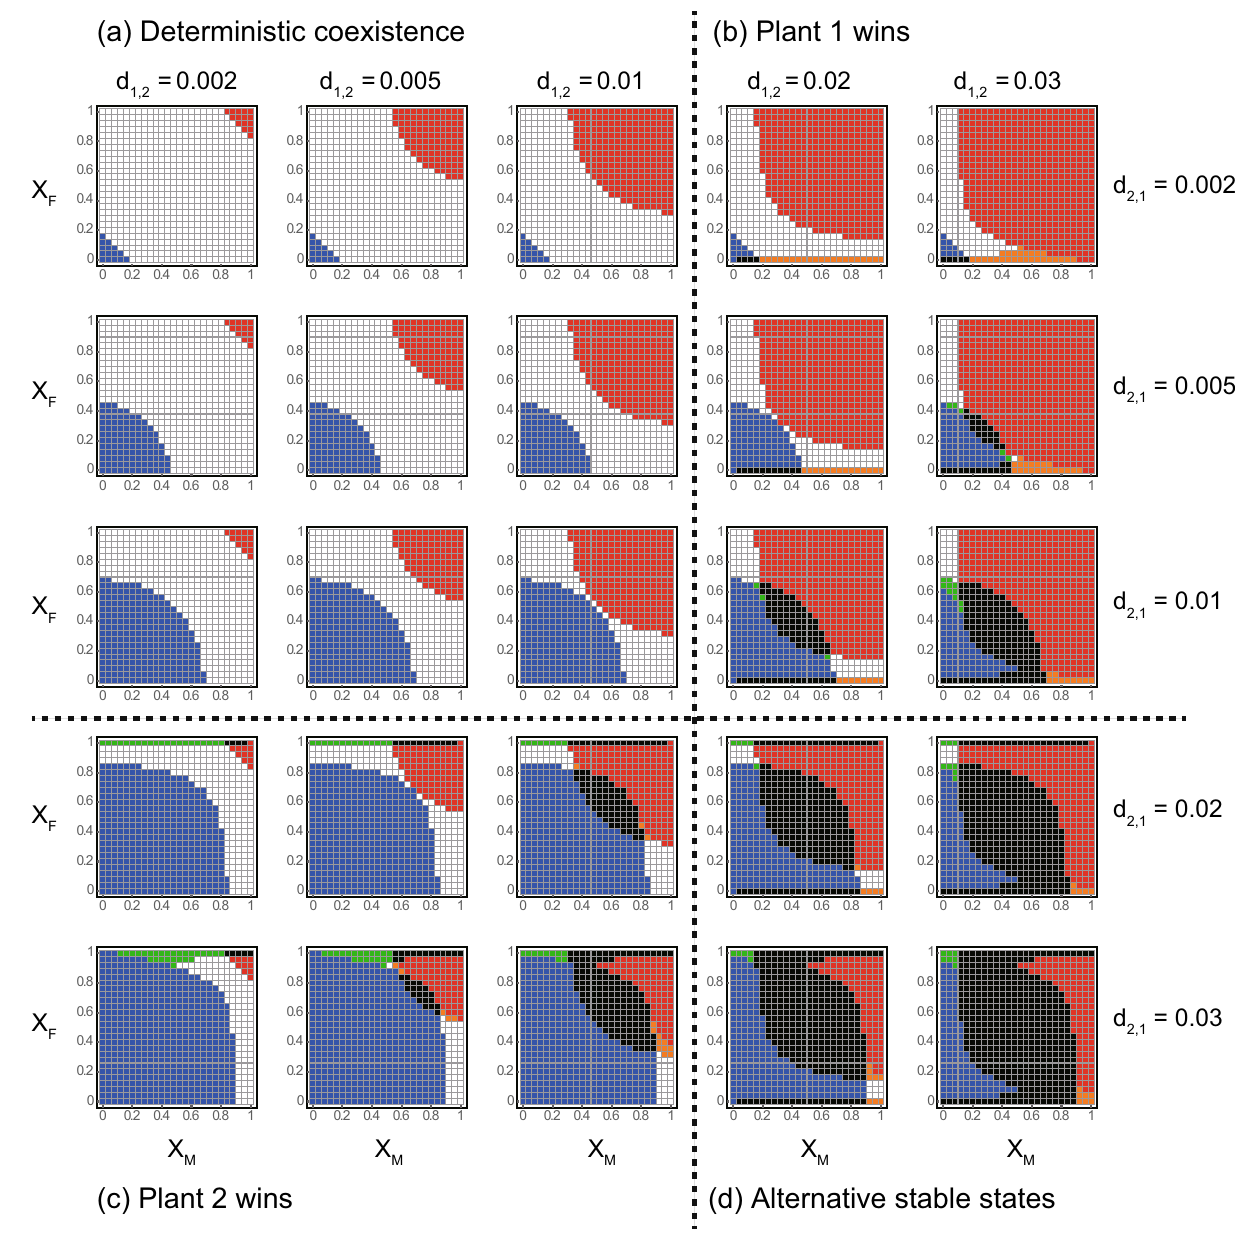
Figure 2. Effects of sex-specific visiting preferences on inter-plant competition and coexistence for different rates of density-dependent plant death. The x and y axes in each panel represent male and female visiting preference on plant 1, respectively. Different colours indicate different steady states: white; the two plants always coexist, red; plant 1 excludes plant 2, blue; plant 2 excludes plant 1, black; either plant survives depending on the initial conditions, orange; plant 1 excludes or coexists with plant 2 depending on the initial conditions, and green; plant 2 excludes or coexists with plant 1 depending on the initial conditions. Panels are arranged according to their density-dependent death rates. From left to light, d 1,2 = 0.002, 0.005, 0.01, 0.02, and 0.03. From top to bottom, d 2,1 = 0.002, 0.005, 0.01, 0.02, and 0.03. Note that d j,i indicates the competition effect from the species j to i. Therefore, without pollinators, the plants exhibit ( a ) deterministic coexistence, ( b ) exclusion of plant 2, ( c ) exclusion of plant 1, and ( d ) trivial alternative stable states in which either plant survive depending on the initial and male abundance, which strengthens (or weakens) the mutualism between plant 2 and pollinator via male preference. Consequently, plant 2 further increases (or decreases) its population abundance. The above effects of sex-specific pollination were symmetrically the same for the third scenario, where plant 2 always outcompeted plant 1 without pollinators (Fig. 2c). In the fourth scenario, either plant survives depending on the initial conditions in the absence of pollinators (Fig. 2d). Here, plant 1 (or 2) tends to be a winner when both sexes strongly prefer plant 1 (or 2) (red or blue